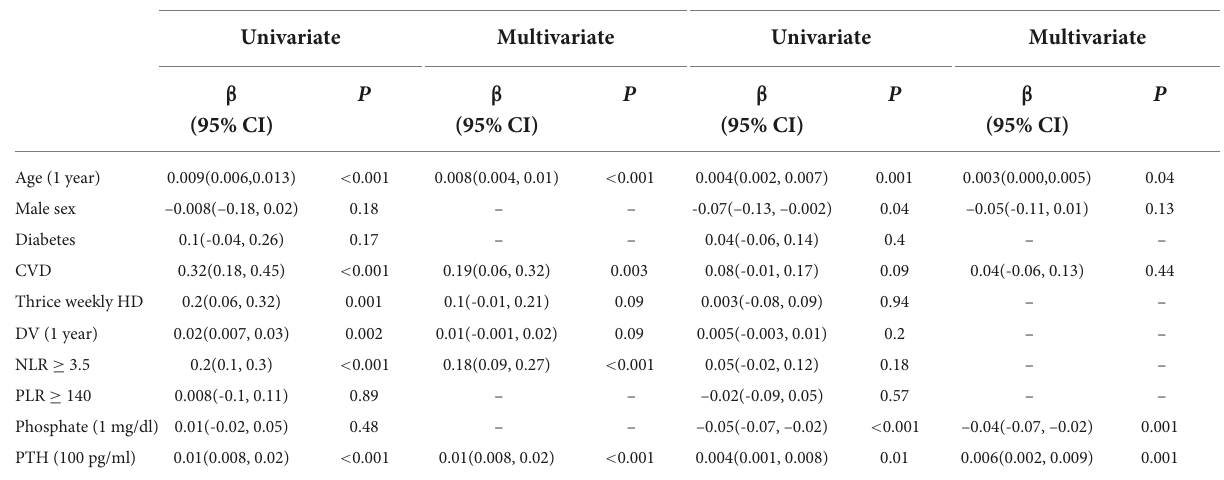
TABLE 2 Generalized linear models of factors associated with nutritional impairment at